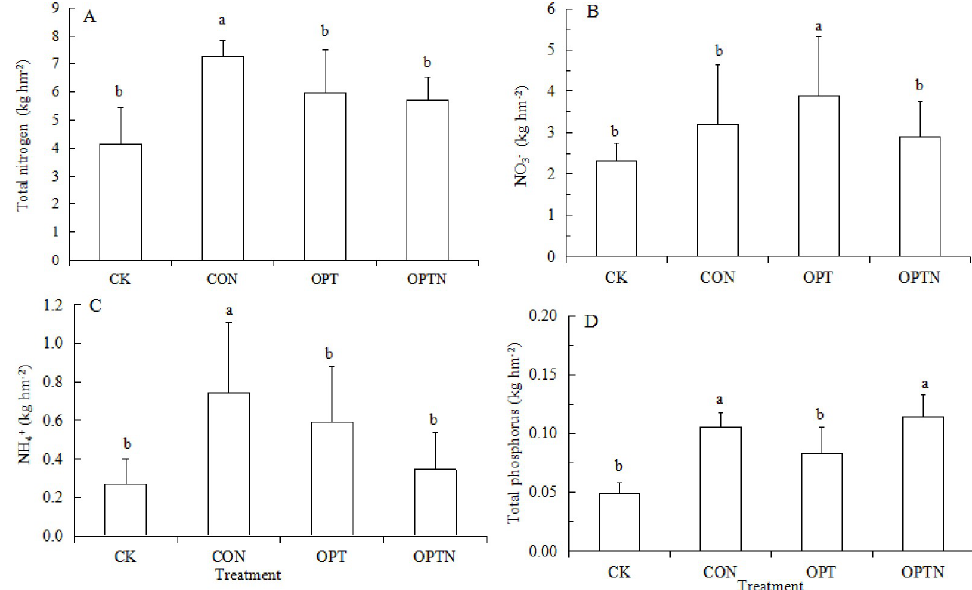
Fig 2. Total N, NO3-, NH4+ and total P loss under four treatments (kg hm -2 ). Data were mean ± standard error (n = 3). Different lowercase letters indicate significant differences among treatments at P < 0.05 level. Bars mean standard